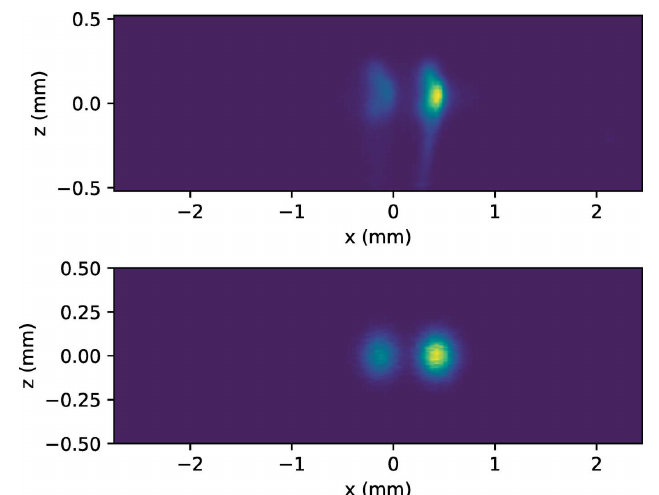
Figure 2 Experimental (top) and ray-traced (bottom) images of the conical analyzer reflected Cu K (cid:2) emission lines.